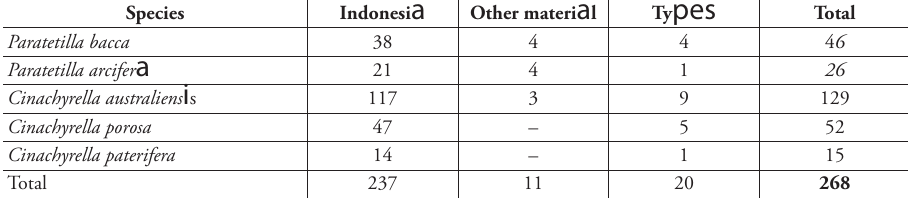
Table 2. Number of samples reviewed per taxon. The column “Indonesia” refers to all samples recently collected in Indonesia (years 2006–2011), “other material” to older specimens in museum collections from Indonesia or other countries; “types” refer to type specimens of valid species and junior